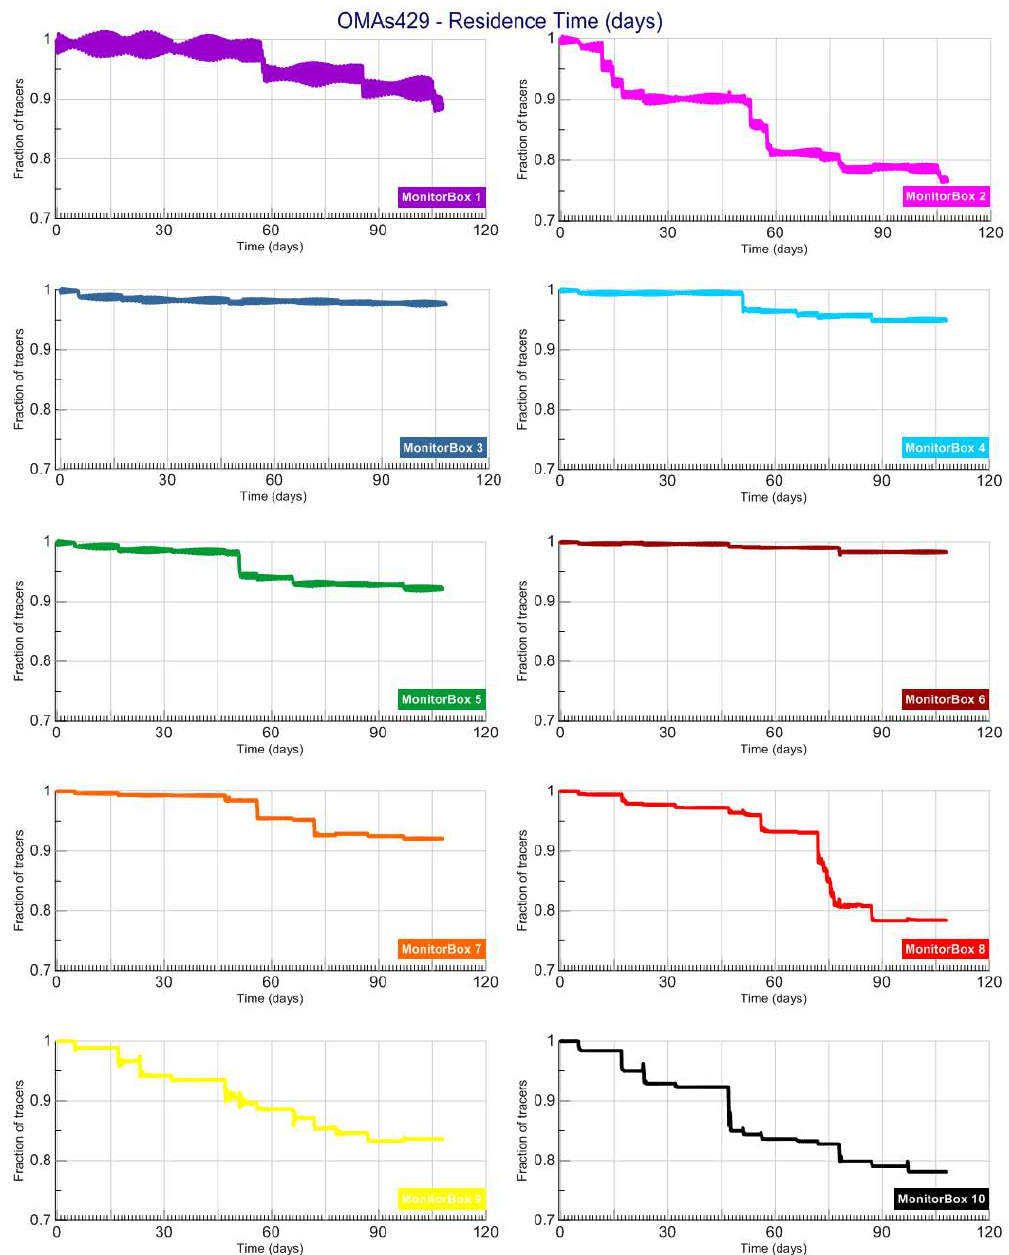
Fig. 3. The residence time of the 429µm OMAs in each monitor box over the simulated period. The monitor boxes are set at increasing depths from box 1 to box 10: 59m, 262m, 357m, 575m, 331m, 945m, 1498m, 2077m, 2657m, and